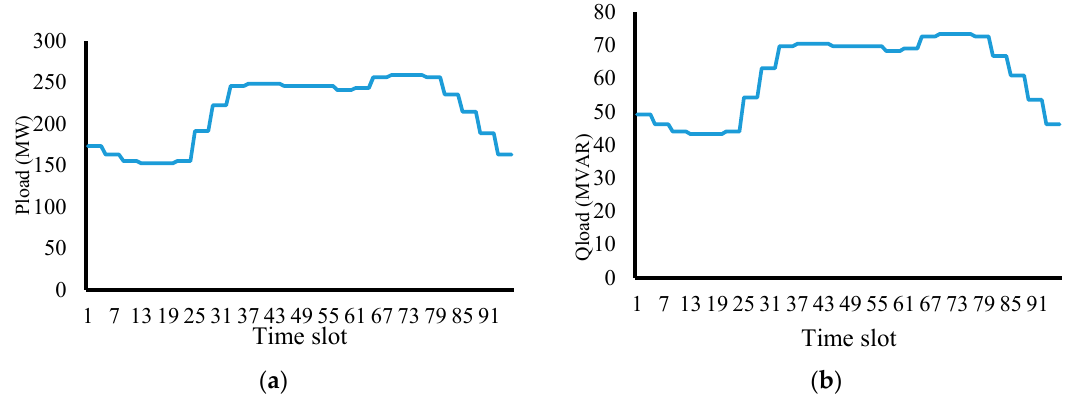
Figure 11. Load curve for IEEE 14 bus system: ( a ) Real power and ( b ) reactive power.